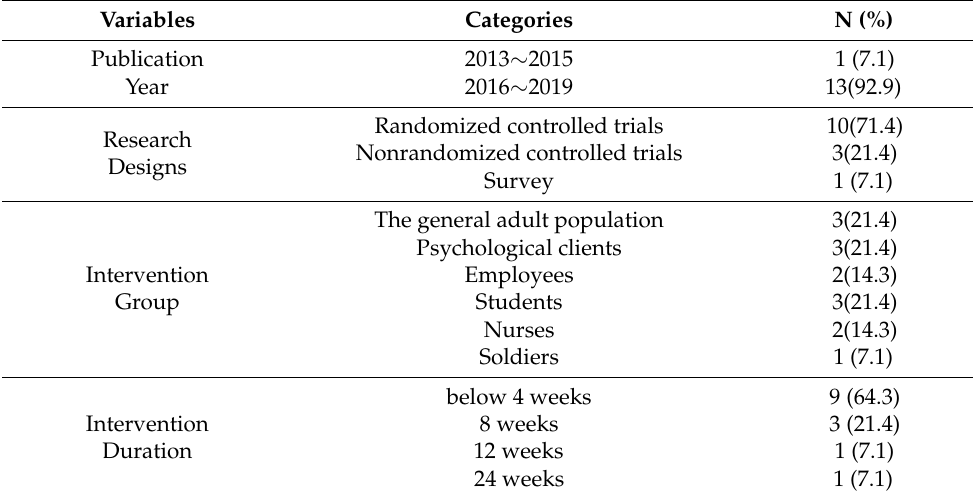
Table 1. General characteristics of selected 14